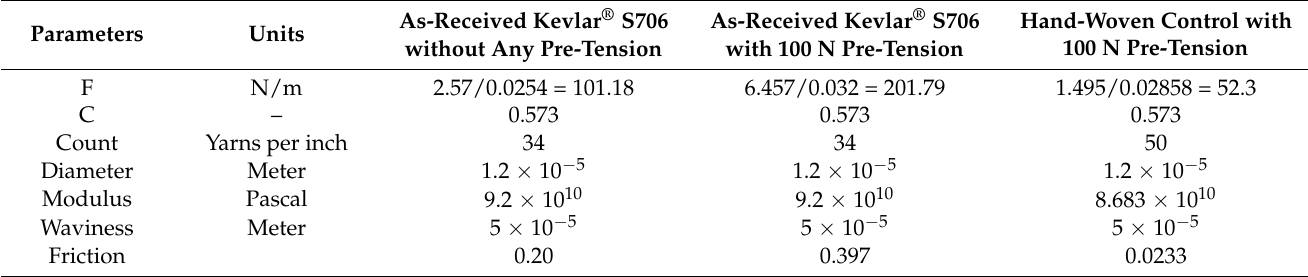
Figure 14. Pull-out response of the As-received Kevlar ® S706 fabric with zero-tail length and without Figure 14. Pull ‐ out response of the As ‐ received Kevlar ® S706 fabric with zero ‐ tail length and without any transverse pre ‐ tension. any transverse pre-tension. Table 2. Sample calculations for friction coefficient using Equation Table 2. Sample calculations for friction coefficient using Equation (2).